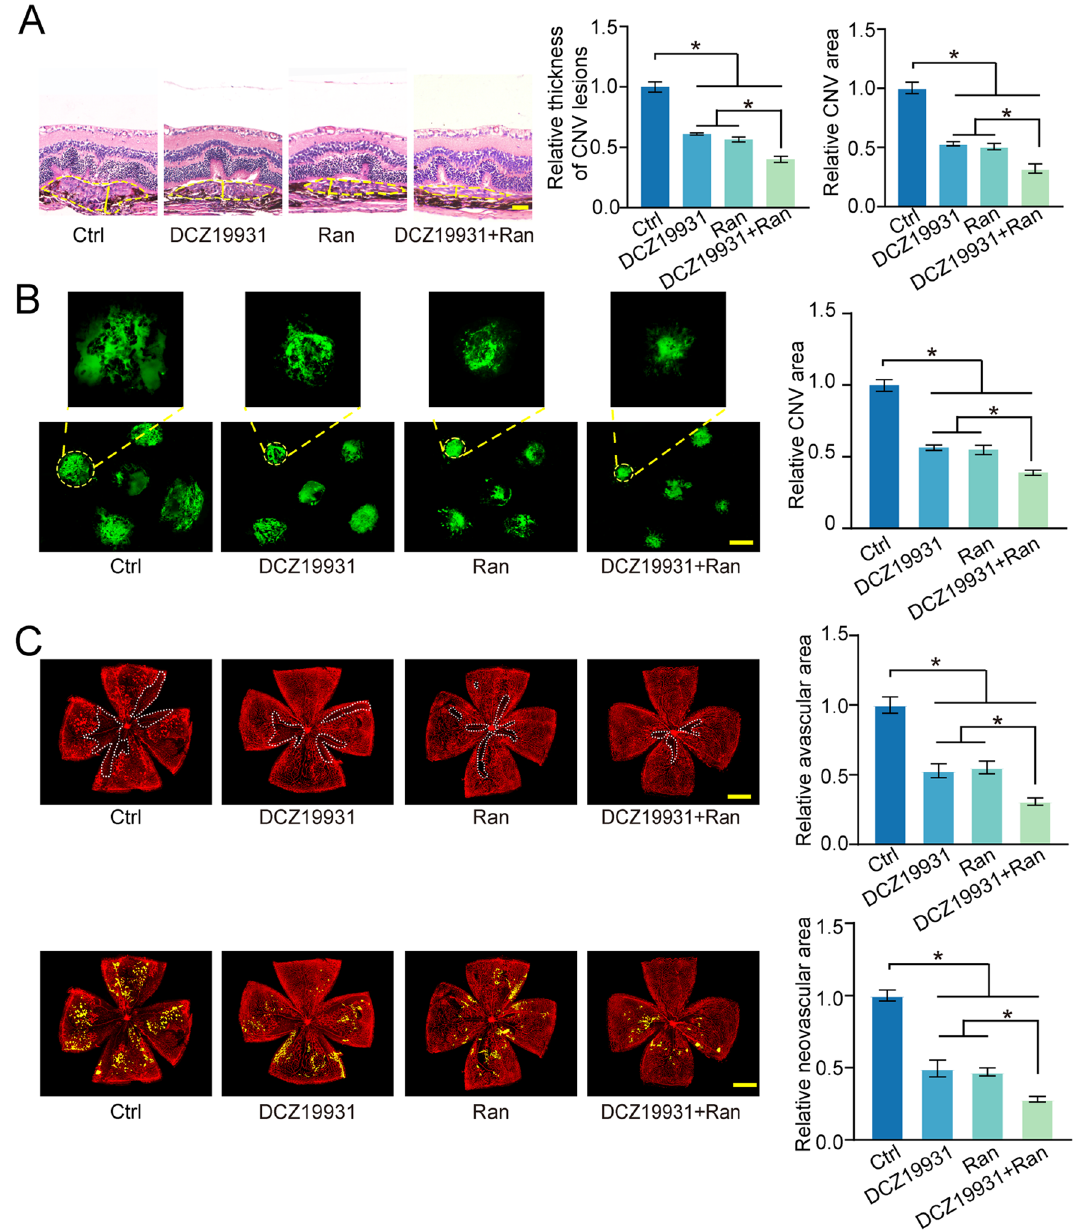
Figure 3. DCZ19931 inhibits ocular neovascularization in vivo. ( A , B ) C57BL/6J mice received intravitreal injections of 10% DMSO (2 μL, Ctrl), DCZ19931 (2 μL, 1 μg/μL), Ranibizumab (2 μL, 10 mg/mL), Ranibizumab (1 μL, 10 mg/mL) plus DCZ19931 (1 μL, 1 μg/μL) immediately after laser injury. The thickness and areas of neovascular were determined by H & E staining ( A , n = 5, scale bar, 50 μm). CNV lesions were visualized by IB4 staining ( B , n = 5, scale bar, 100 μm). ( C ) OIR mouse pups at P12 received intravitreal injections of 10% DMSO (1 μL, Ctrl), DCZ19931 (1 μL, 1 μg/μL), Ranibizumab (1 μL, 10 mg/mL), 1 μL of Ranibizumab (10 mg/mL) plus DCZ19931 (1 μg/μL), respectively. The retinas were harvested on P17 and then stained with GS-IB4 staining to observe retinal vessels. White dashed lines highlighted avascular areas; Yellow area indicated angiogenic regions (n = 5, scale bar, 200 μm). Statistical significance was evaluated by one-way ANOVA followed by Bonferroni post hoc test. * P < 0.05 indicated significant difference between the marked